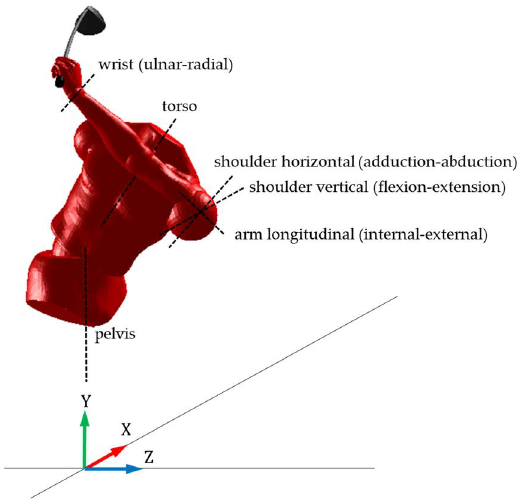
Figure 1. Biomechanical rotational DOFs. Axes of rotation represented by dashed